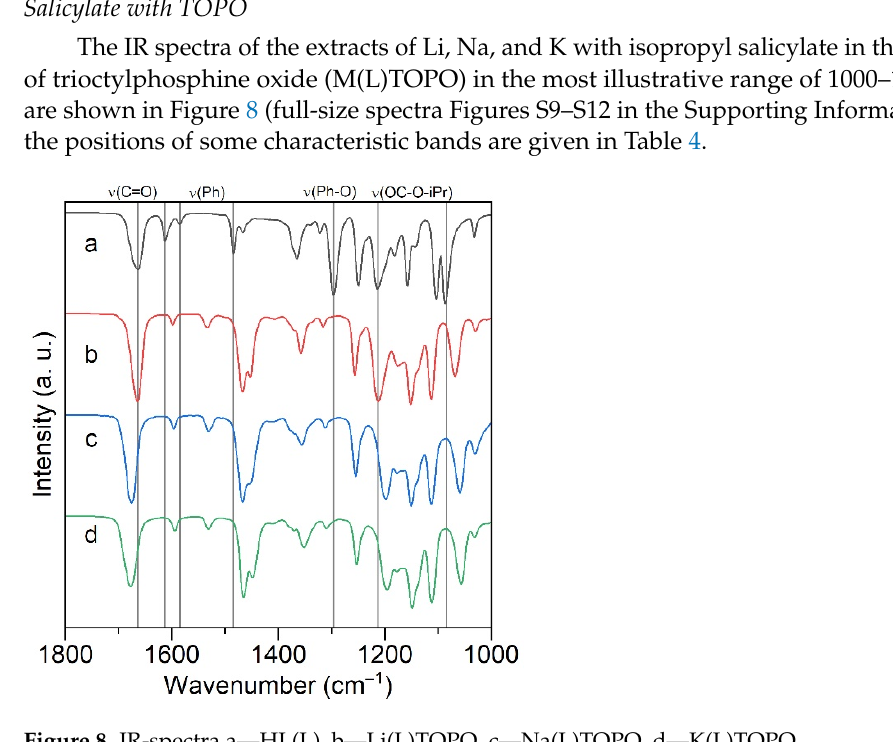
Table 3. Lithium distribution coefficient, separation coefficients Li/Na and Li/K.